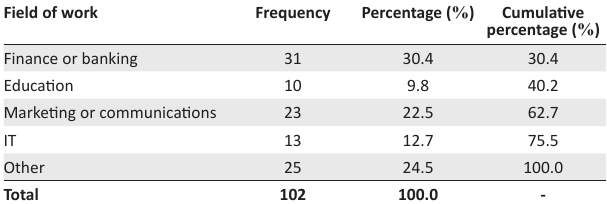
TABLE 7: Field of